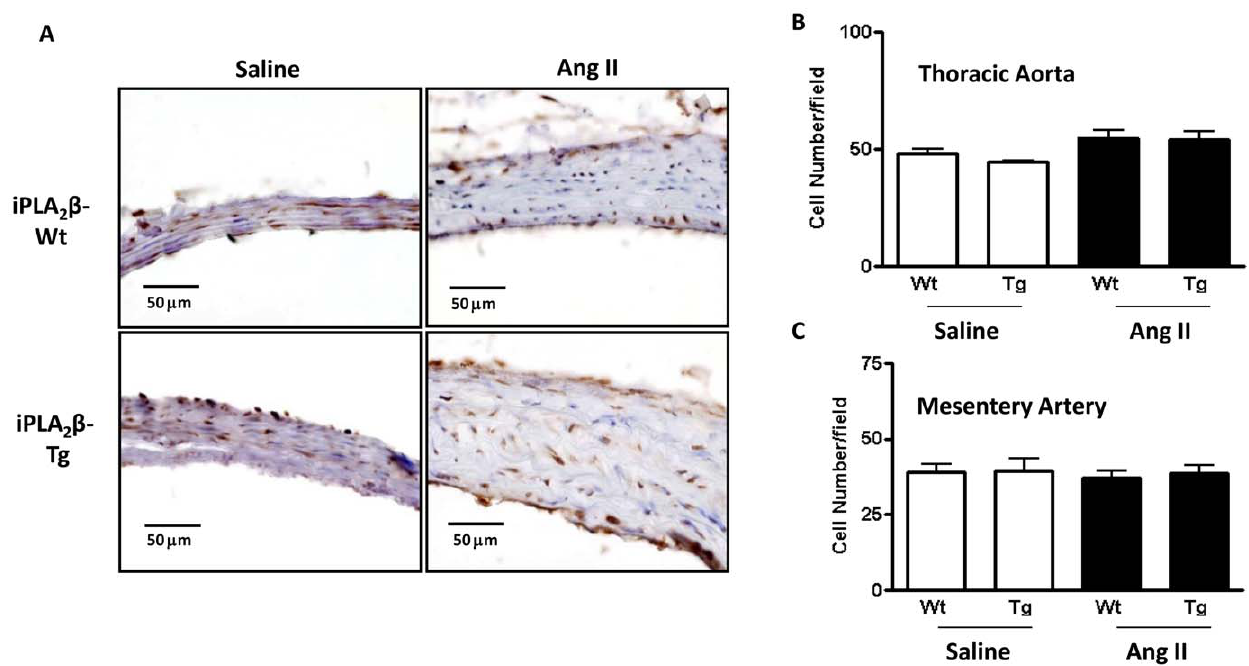
Figure 4. Lack of difference in cell proliferation between iPLA 2 b -Tg and iPLA 2 b -Wt mice by Ang II infusion. Mice were infused with saline or Ang II (500 ng/kg/min, 14 days) and thoracic aortas were isolated and sectioned. ( A ) are representative images of the sections stained with anti-PCNA antibody. ( B ) and ( C ) are summaries of the cell number analysis using HE stained sections. n=8.